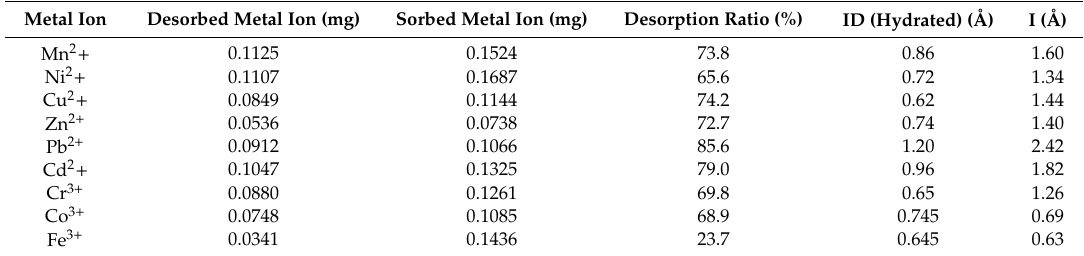
Table 9. Desorption ratios of the metal ions from the P (AA / Kry23-DM) SAP a and ion diameters (Å) of hydrated of the metal ions (ID) ionic diameters b